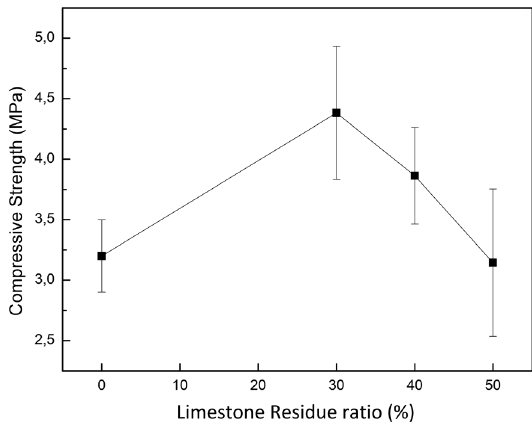
Figure 5. Compressive strength curve for all compositions